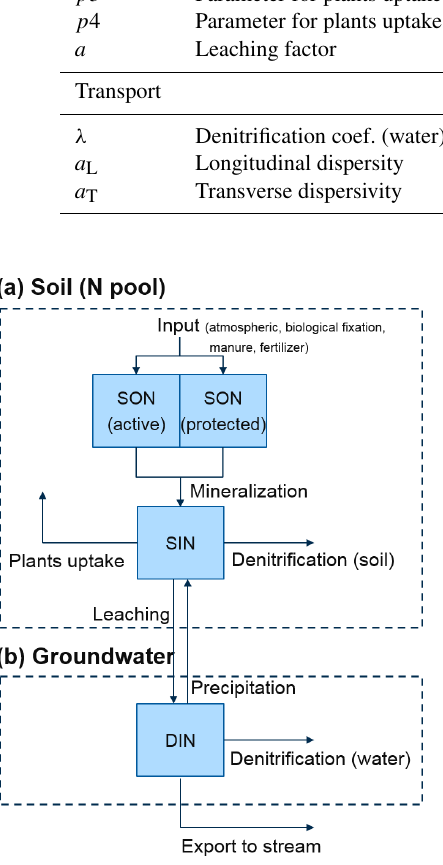
values reported in Van Meter et al. (2017). The sowing date p 4 is fixed as 63 d according to the fact that sowing activi- ties and plant growth start in early March. Longitudinal and transverse dispersivity values were 8 and 0.8 m, respectively. (Table